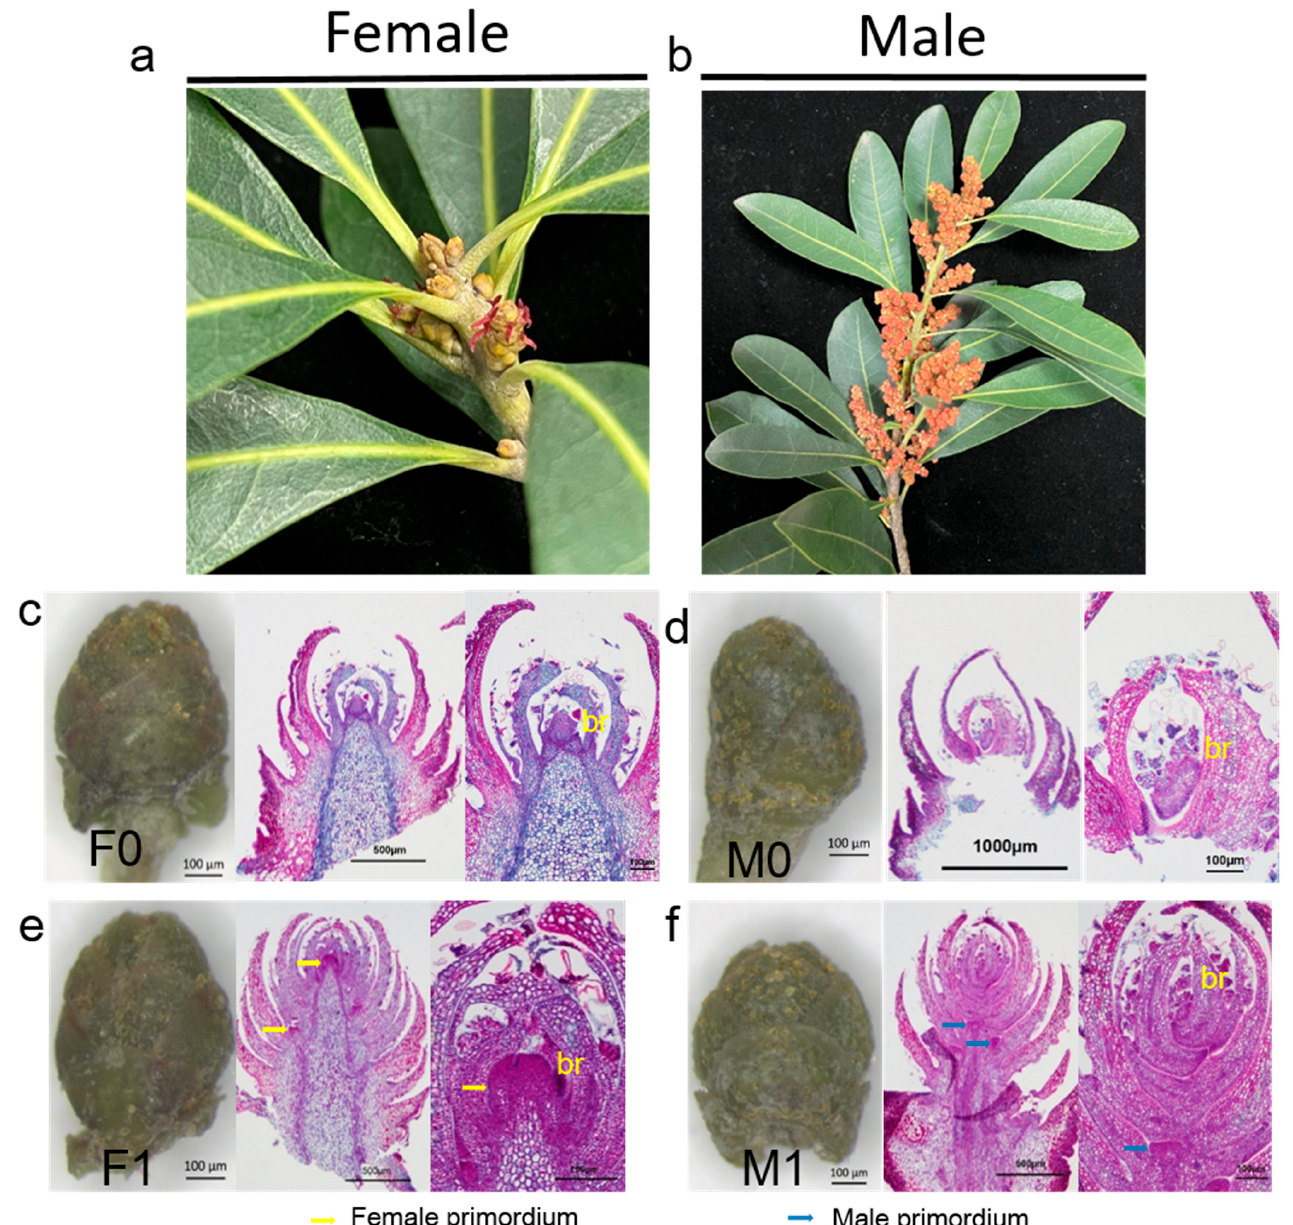
Figure 1. The male and female floral buds of the red bayberry. Female flower ( a ) and male flower ( b ) of the red bayberry. Male and female floral buds before sexual differentiation ( c , d ), and with female and male primordia ( e , f ). br, bracts. The figures ( e , f ) have been published in a previous study